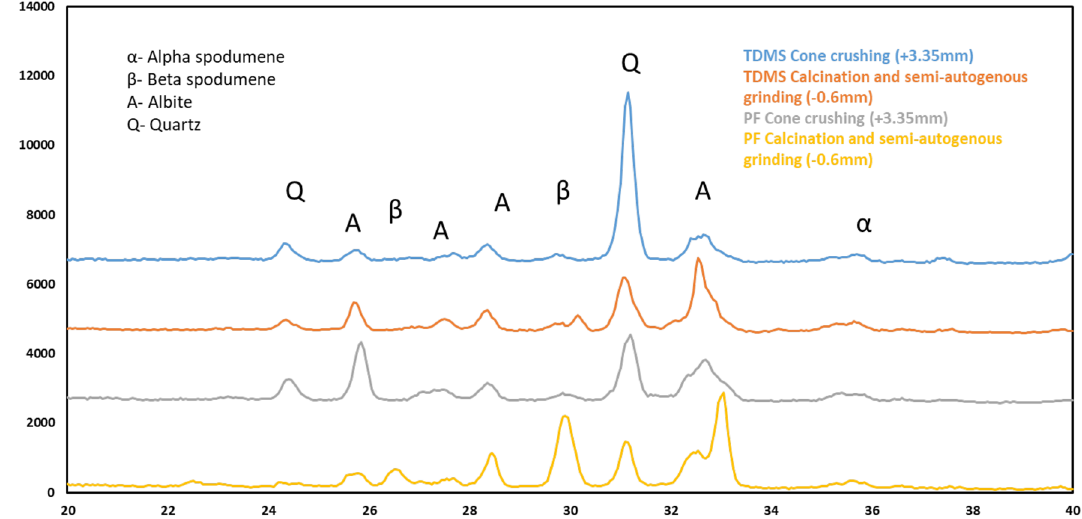
Figure 6. XRD for two calcined finest fractions (−0.6 mm) and two non-calcined coarsest fractions (+ 3.35